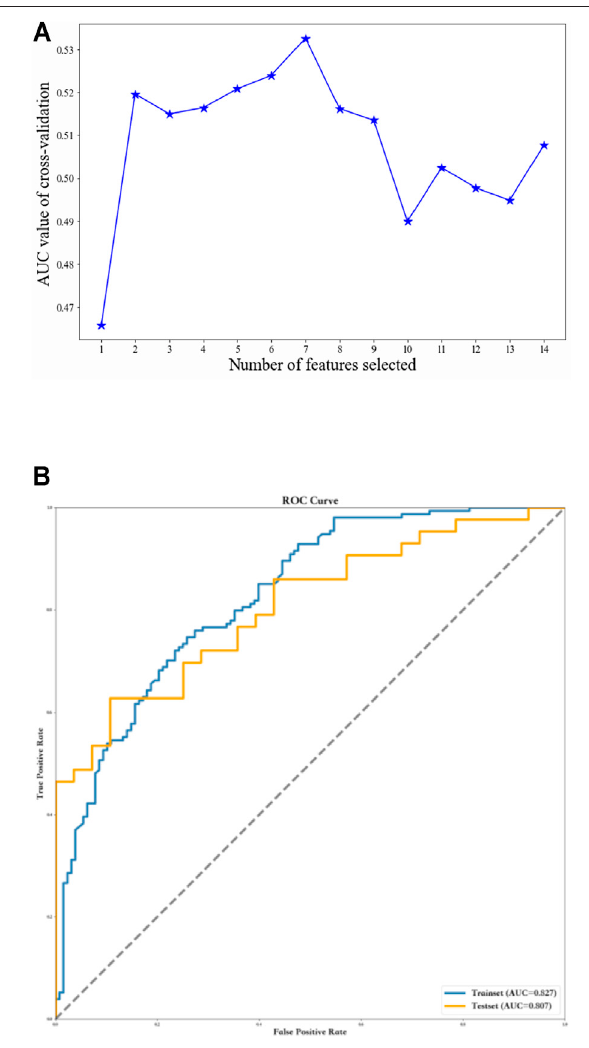
FIGURE 2 | Using recursive feature elimination method to screen the optimal variables. (A) Seven variables were employed for the optimal GBDT algorithm. (B) ROC curves of the GBDT model based on selected variables.